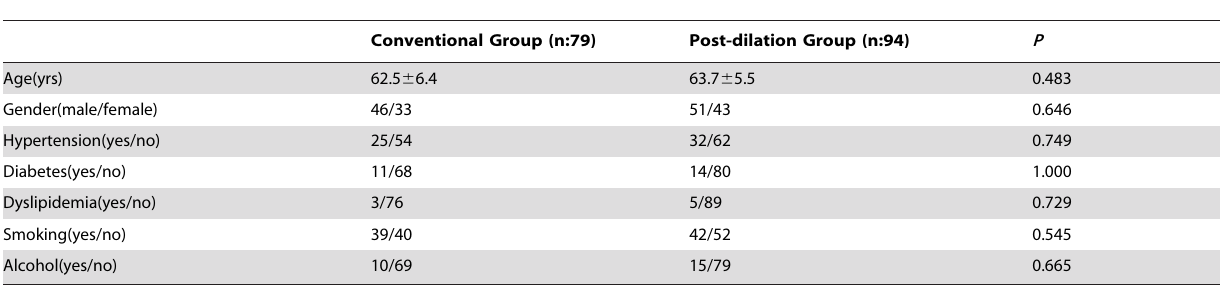
Table 1. Clinical Features of Patients in both groups.